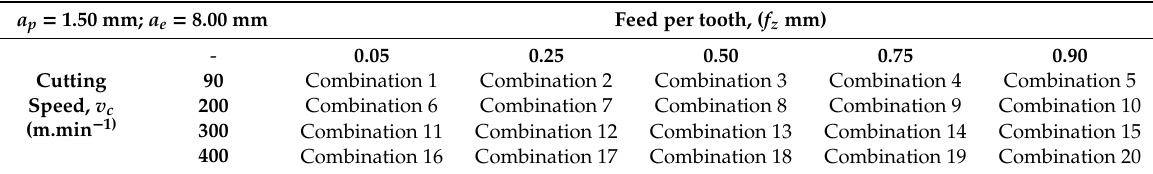
Table 4. Set of specimens used for force loading analysis.